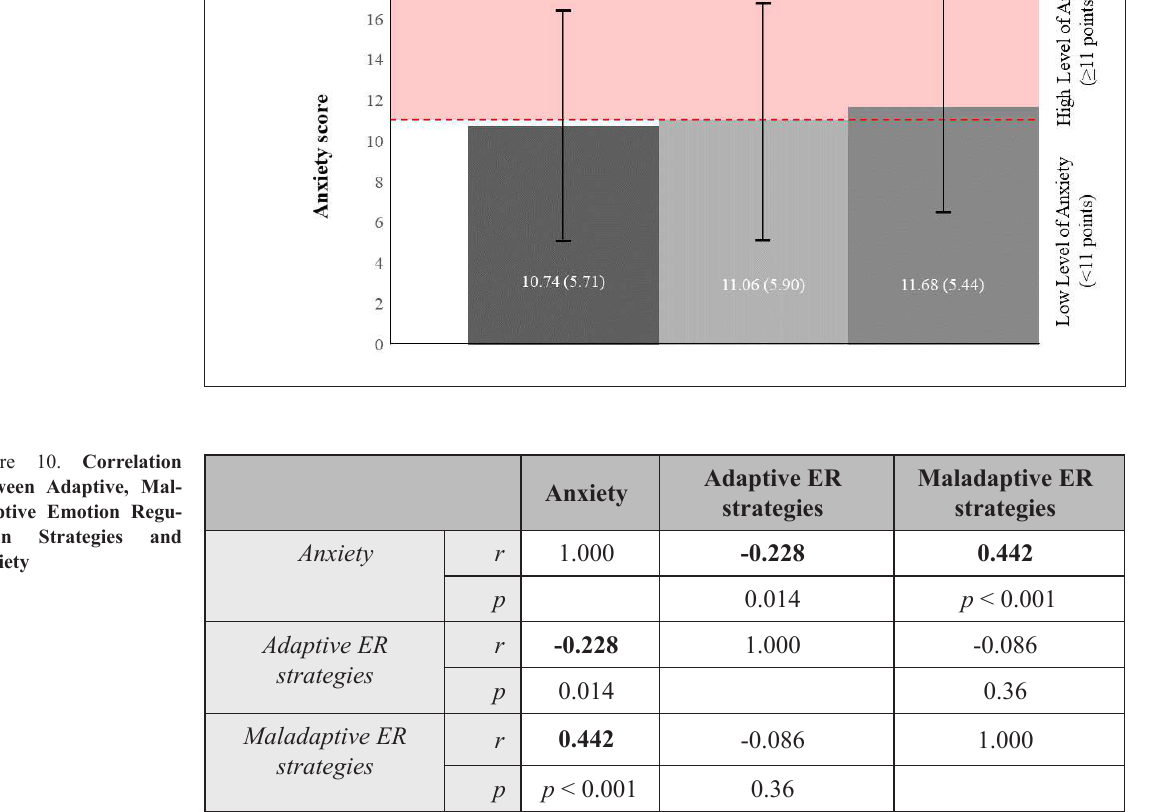
Figure 9. Comparison of Anxiety Levels between Years of Study